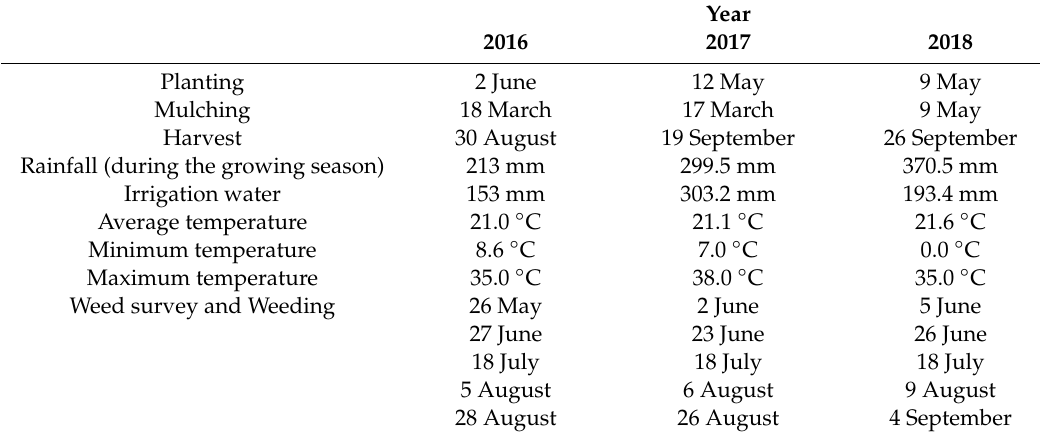
Table 6. Timeline of actions during study years (open-field tomato, Gödöll˝o, Hungary,